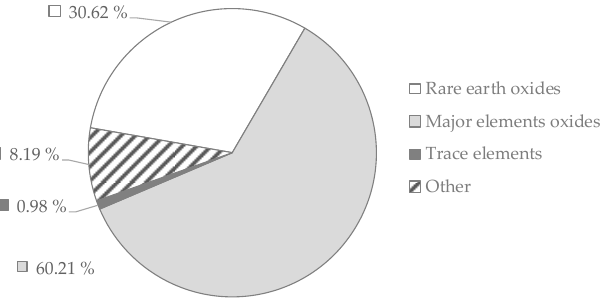
Figure 2. Overview of the chemical composition of the monazite concentrate (MEO = oxides of major elements).